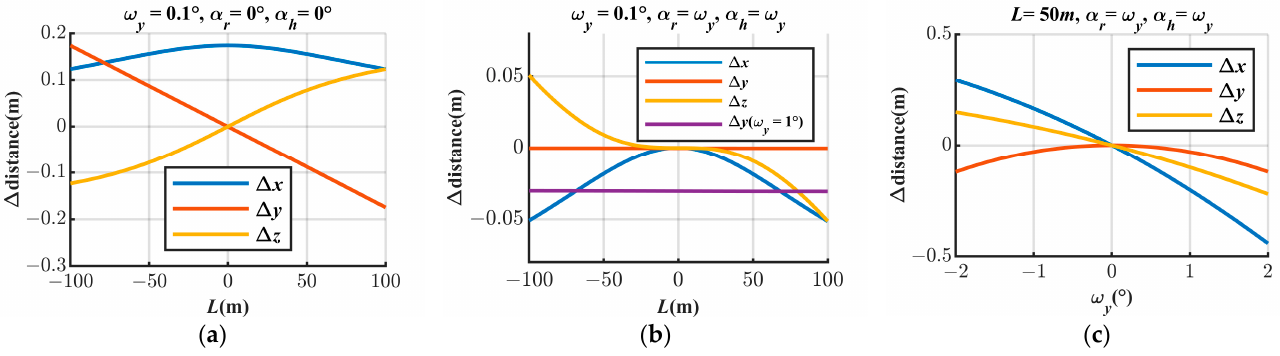
Figure 15. The effect of ω y on the point coordinates. ( a ) Without α r and α h compensation, ∆ x , ∆ y , ∆ z change with L ; ( b ) After using roll angle α r and heading angle α h compensation, when ω y = 0.1 ◦ , ∆ x , ∆ y , ∆ z change with L . In order to show the change trend of ∆ y , a change curve of ∆ y when ω 𝑦 = 1° is added; ( c ) After using roll angle α r and heading angle α h compensation, when L = 50 m, ∆ x , ∆ y , ∆ z change with ω y